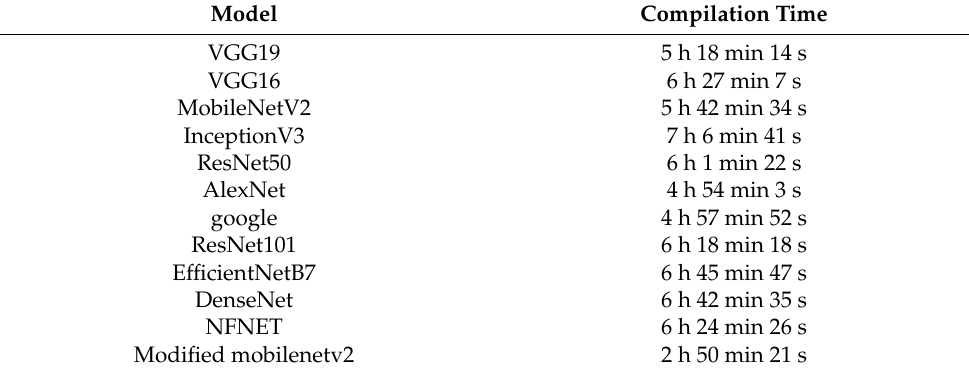
Table 8. Compilation time of the models.